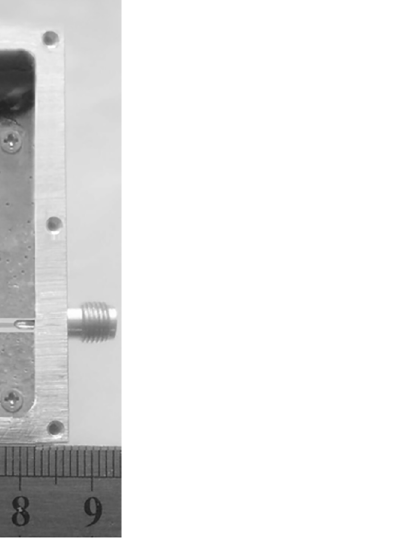
Fig 8. Prototype of designed pulse